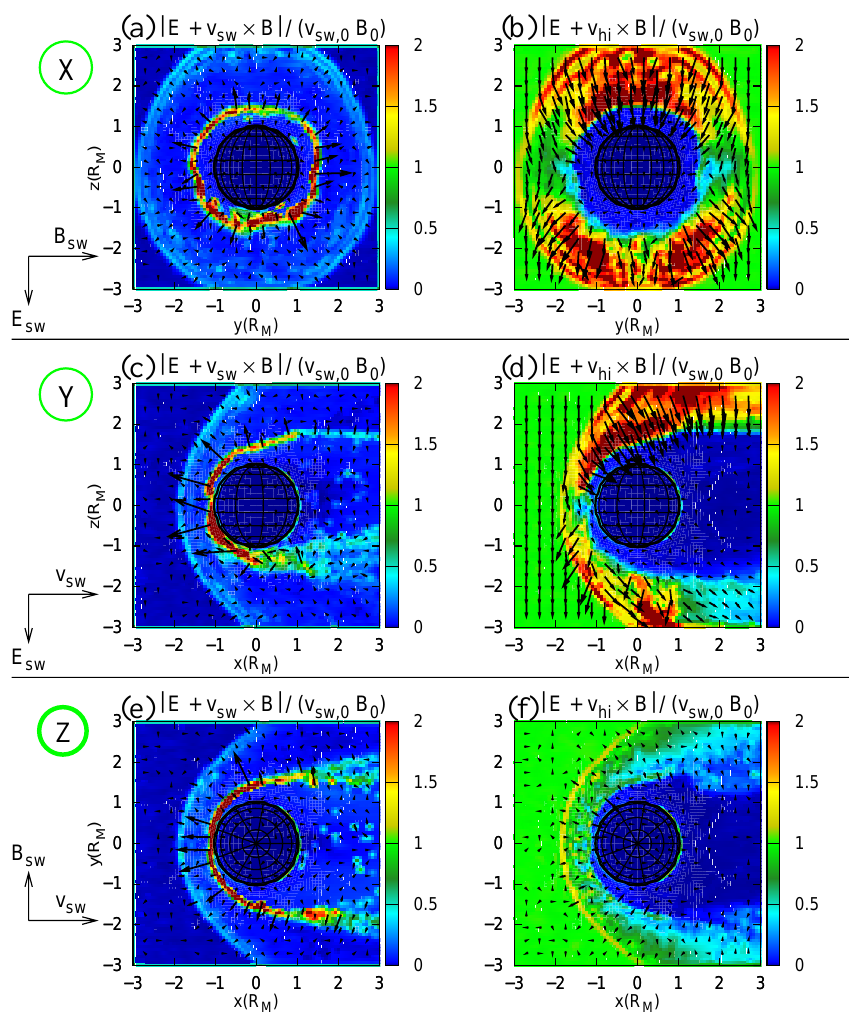
Fig. 3. Plasma environment of Mars – Lorentz forces. The figure diplays the Lorentz forces acting on solar wind ( SW ) and ionospheric heavy ions ( HI ) for the terminator plane: (a) and (b) , the polar plane: (c) and (d) , and the equatorial plane: (e) and (f) . The arrows denote the projection of the force vectors on the cutting planes. The Lorentz force is given in units of v SW, 0 B 0 , i.e. the quantity displayed in the figure is dimensionless. The cutting planes (x = 0 ) , (y = 0 ) and (z 0 ) are denoted by the abbreviations X, Y and Z, respectively. Mach numbers of the upstream plasma flow: M A = 10 . 0 (alfv´enic), M S =5.1 (sonic) and M MS =4.5